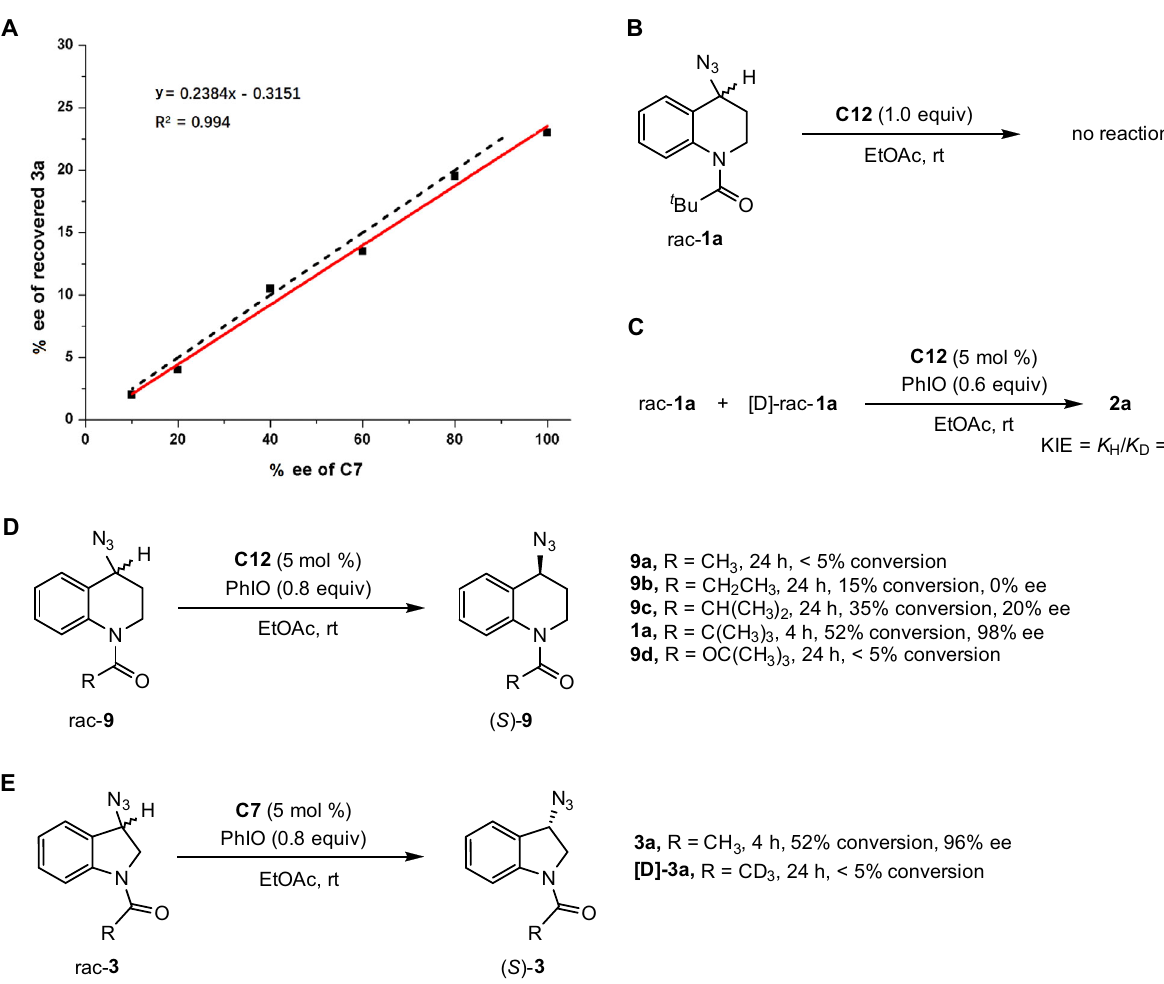
Fig. 5 Control experiments. A Plot of enantiomeric excess of recovered 3a versus the enantiomeric excess of C7 at 20% conversion. The dotted line symbolized the linear correlation. B Stoichiometric Mn(salen) C12 mediated control experiment in the absence of PhIO. C The intermolecular kinetic isotope effect. D The N -acyl substituent effect for THQ-based azides. E Deuterated control experiment of indoline-based